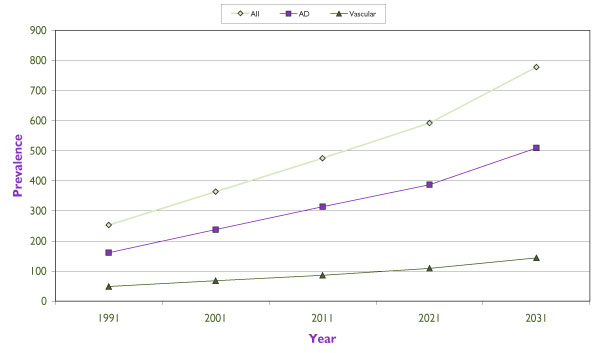
Projected Prevalence of Dementia (× 1,000) Canada, 1991–2031. Based on Table 11 in: Canadian Study of Health and Aging Working Group. Canadian Study of Health and Aging: study methods and prevalence of dementia. CMAJ 1994;150:899–913.